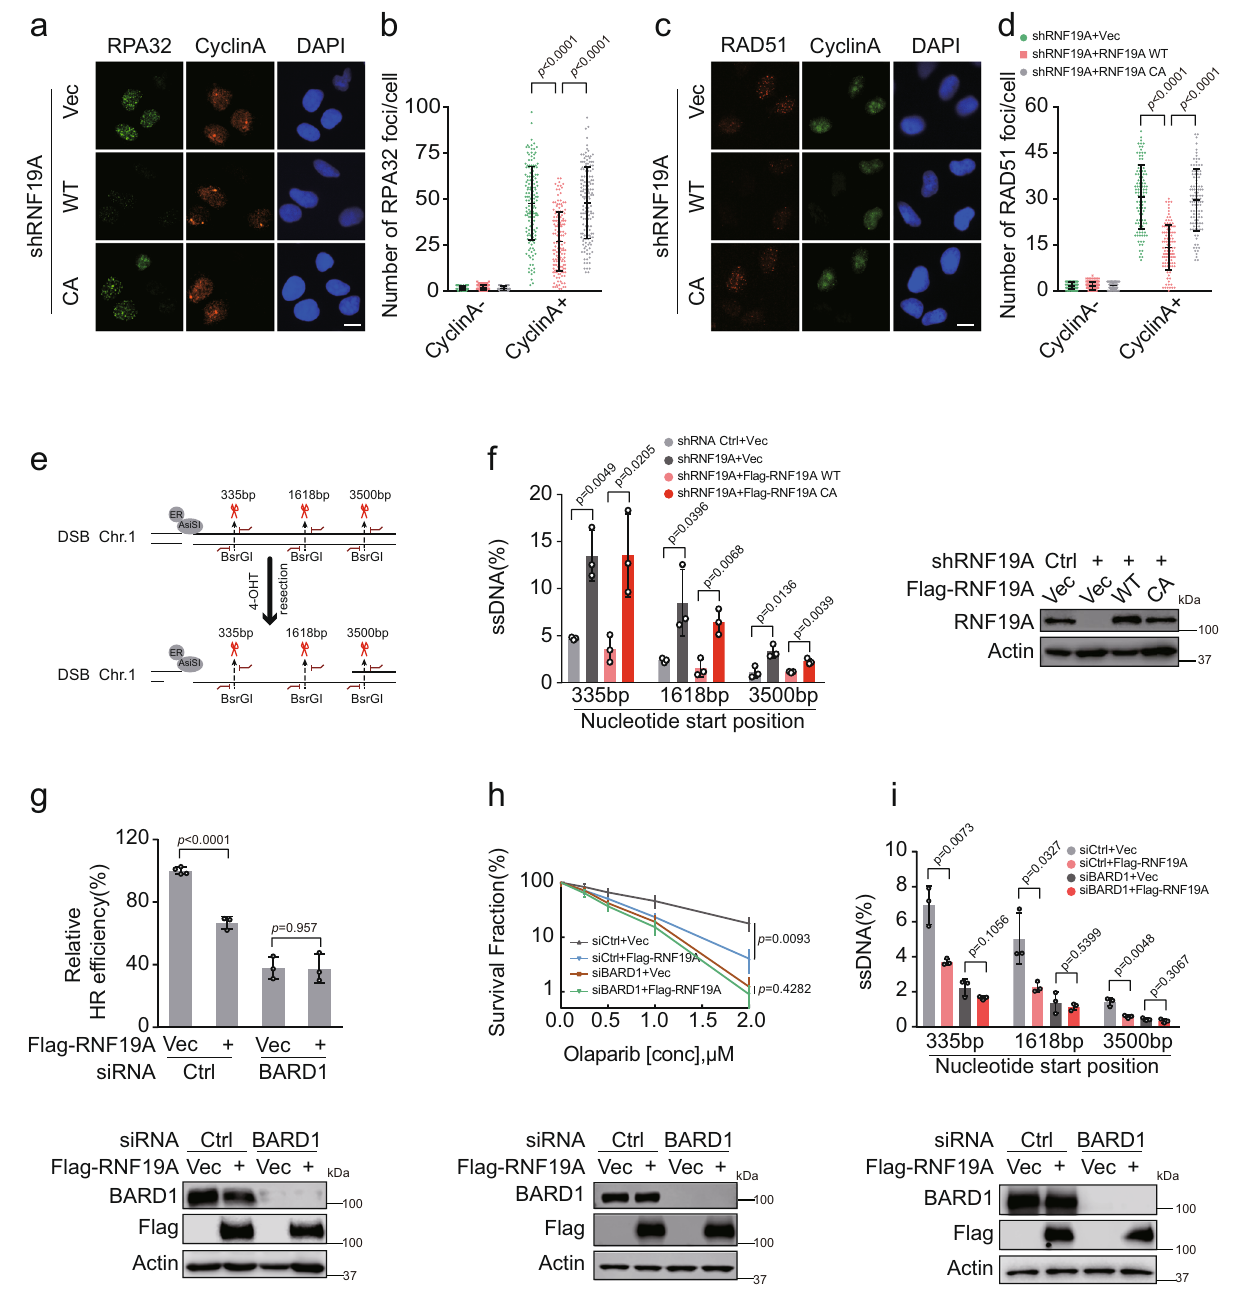
Fig. 3 RNF19A functions in end resection through its catalytic activity and in a BARD1-dependent manner. a – d RNF19A knockdown U2OS cells stably expressing Vec, WT, or C316A(CA) Flag-RNF19A were treated with IR (2 Gy, 3 h for RPA32 and 2 Gy, 5 h for RAD51). Cells were fi xed and immunostained as indicated ( a and c ). Cyclin A was used as a marker of S/G2 phase. Quanti fi cation of focus signals per cell (each dot represents a single cell, n = 100 for group Cyclin A-; n = 150 in b ; and n = 110 in d for group Cyclin A + ) is shown in b and d . Scale bars, 10 μ M. Error bars represent means ± s.d. of three independent experiments. e Schematic of ER- Asi SI system for quanti fi cation of DNA resection. Restriction enzyme Asi SI is fused to the estrogen receptor (ER) and can be induced to the nucleus and generate DSBs at sequence-speci fi c sites by 4-OHT. The genomic DNA was extracted and quanti fi cation of ssDNA generated by resection was measured by qPCR. The primer pairs for DSBs are across BsrGI restriction sites. f RNF19A knockdown ER- Asi SI U2OS cells were reconstituted with Vec, WT, or C316A(CA) Flag-RNF19A and were pretreated with 300 nM 4-OHT for 4 h to induce DSBs. Genomic DNA was extracted and digested or mock digested with BsrGI overnight. DNA-end resection adjacent to indicated sites was measured by qPCR. g HEK293T cells stably expressing Vec or Flag-RNF19A were transfected with control (Ctrl) or BARD1 siRNAs for 48 h. HR ef fi ciency was determined using the HR reporter assay. h U2OS cells stably expressing Vec or Flag-RNF19A were transfected with control (Ctrl) or BARD1 siRNAs were subjected to colony formation assay for assessment of response to Olaparib. i U2OS ER- Asi SI cells stably expressing Vec or Flag-RNF19A transfected with control (Ctrl) or BARD1 siRNAs for 48 h and were pretreated with 300 nM 4-OHT for 4 h before digest and measurement of DNA resection. Error bars represent means ± s.d. of three ( f , h , and i ) or four ( g ) independent experiments. p values are determined by unpaired two-sided t test in b , d and f – i . Source data are provided as a Source Data fi